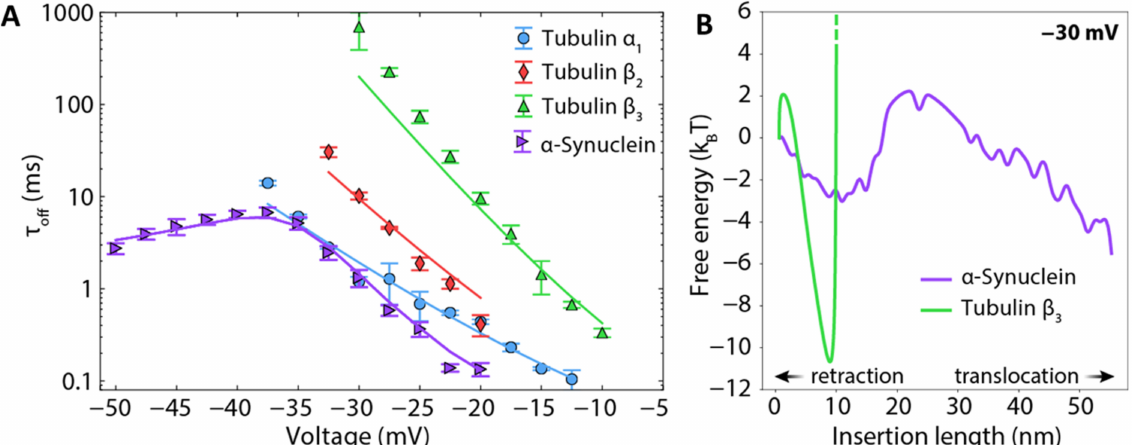
Figure 7. Energy landscape modeling of release rates of the CTTs of various tubulin isotypes and wild-type α Syn. ( A ) Experimental data (markers) and energy landscape model (solid lines) show excellent agreement between the model and experiment with few free parameters. Each data point is a mean of 3–5 independent experiments, and error bars represent the standard error of the mean. Data were adapted from Rostovtseva et al., J. Biol. Chem . (2018). ( B ) Free energy profiles underlying the curves in ( A ). The reaction coordinate is the length of the polypeptide strand that has been inserted into the VDAC